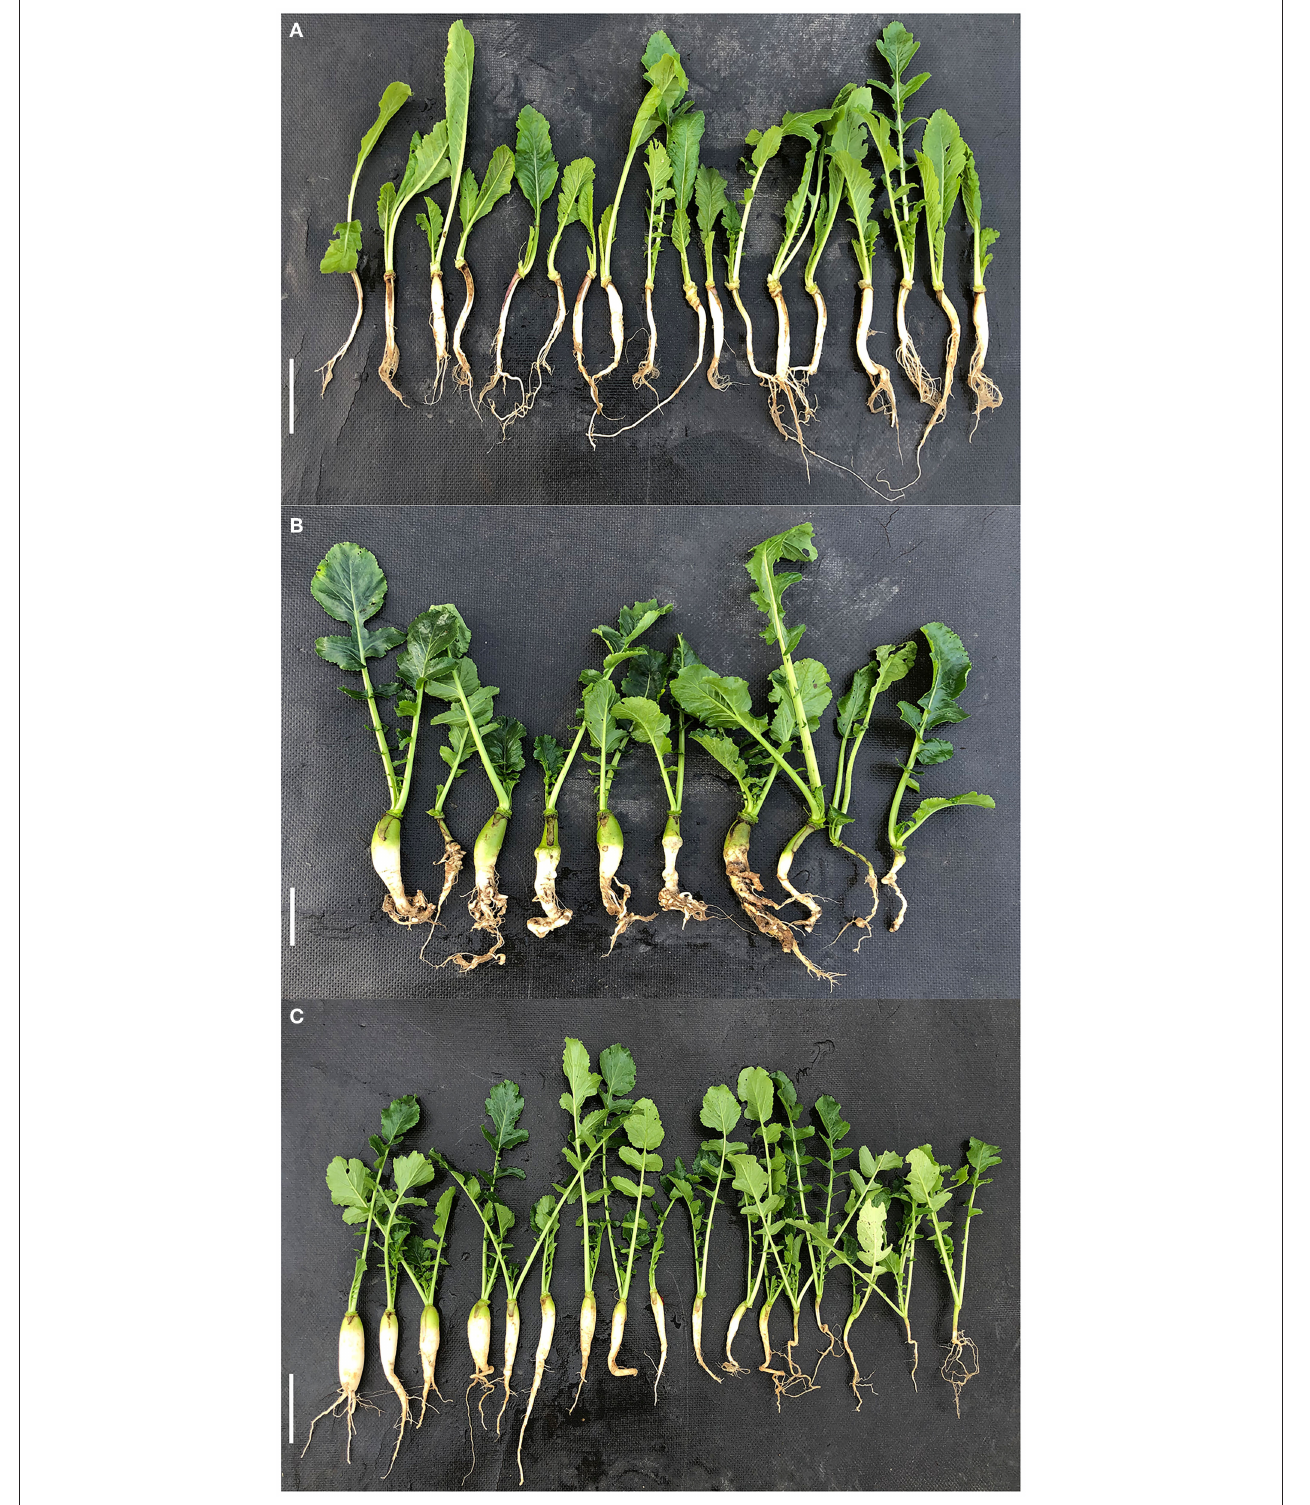
FIGURE 1 | Phenotype identification of two parental radish lines and their crossed offspring after inoculation with Pb10. (A) Resistance parent “GLX” (P1). (B) Susceptible parent “XNQ” (P2). (C) Phenotypes of F 1 offspring individuals. Bar scale = 10cm.